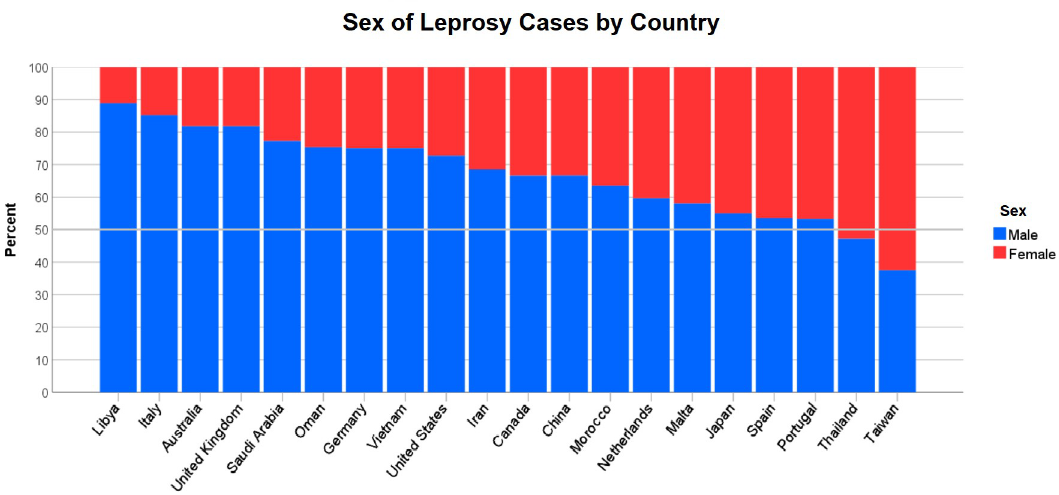
Fig 3. Percentage of male and female leprosy cases.